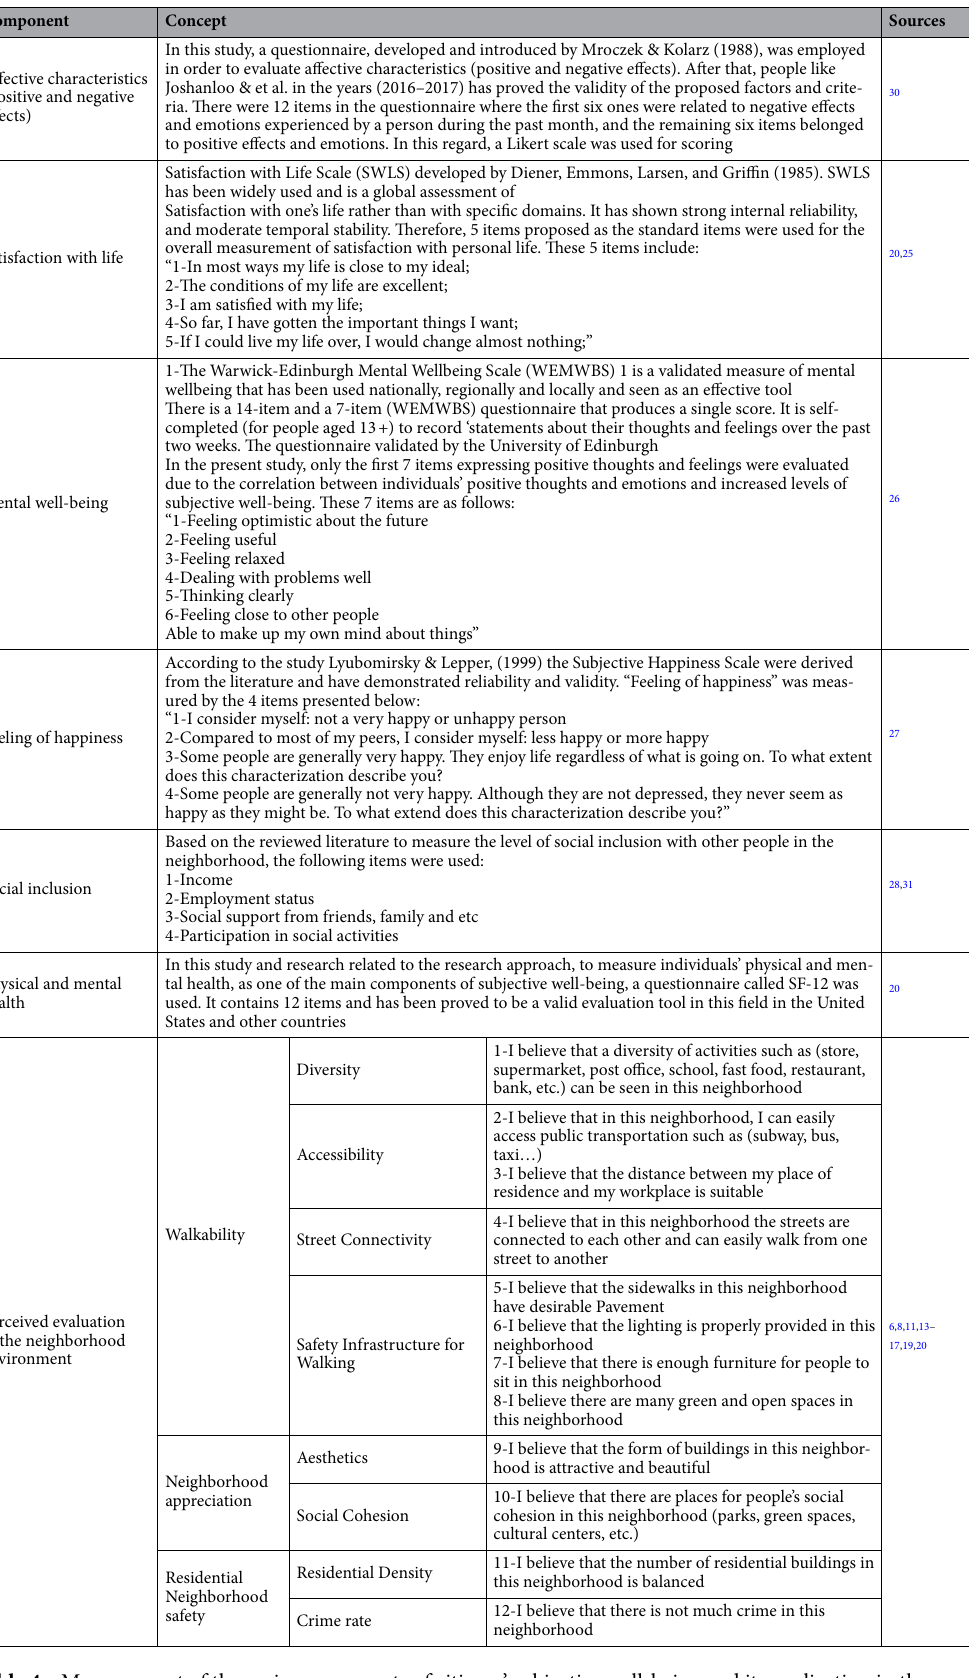
Table 4. Measurement of the main components of citizens’ subjective well-being and its application in the research